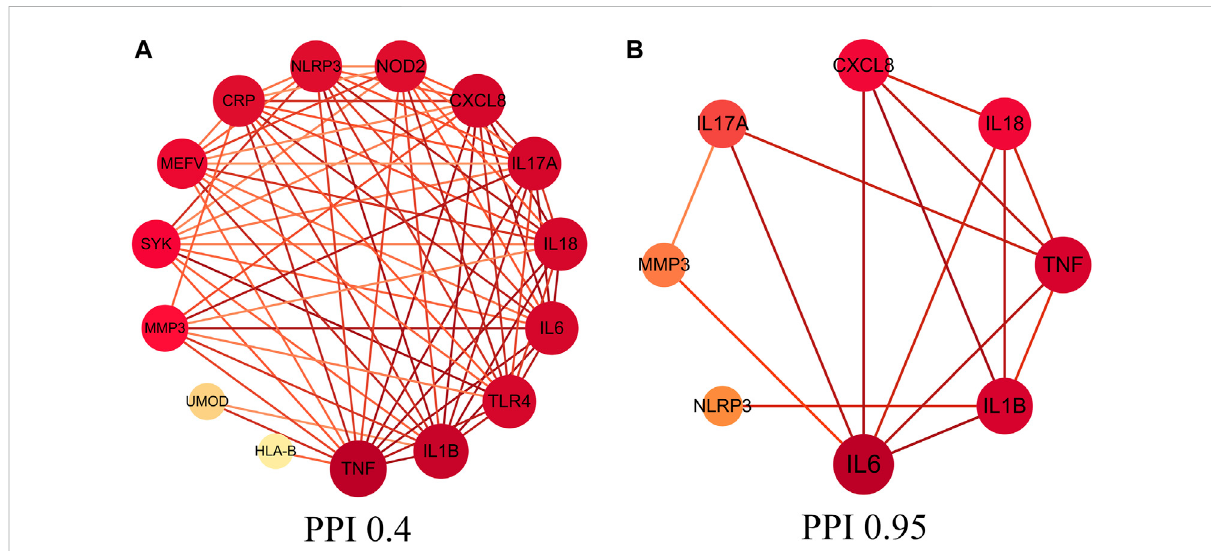
FIGURE 1 Protein-protein interaction (PPI) network. (A) PPI network of protein target, (B) PPI network of core protein target (con fi dence >